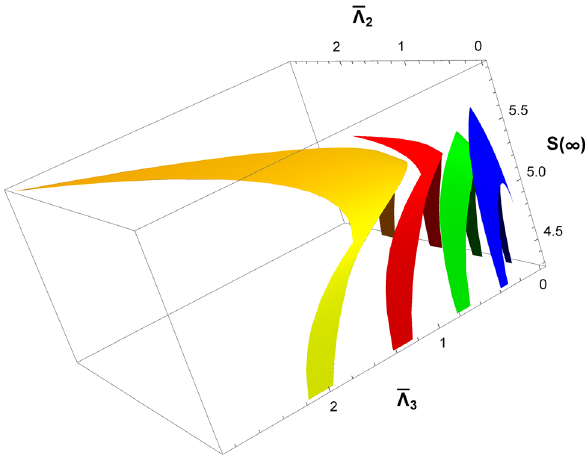
Fig. 3 Dependence of the entanglement entropy S ( ∞ ) on the cosmo- logical constants ¯ Λ 2 and ¯ Λ 3 of pair of entangled universes produced in the decay processes. More elongated shapes corresponds to the higher value of the mass m Φ of the parent 1